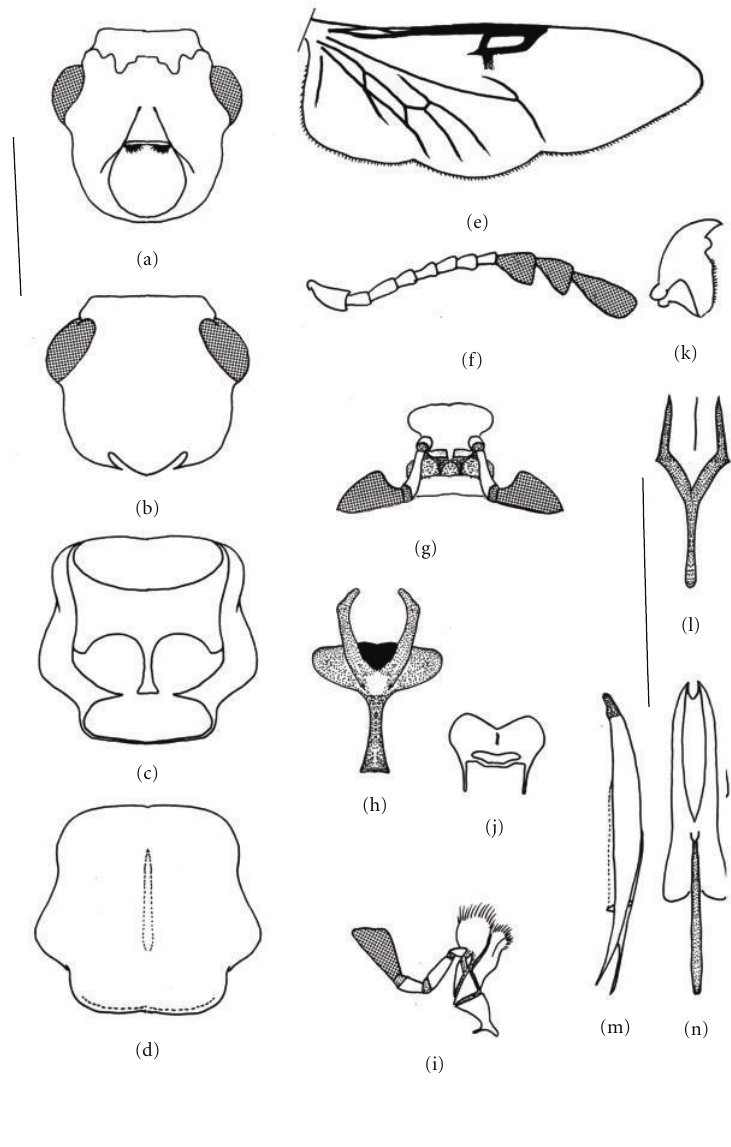
Figure 10: Various organs of Neopylus nahuelbutensis . (a, b) Head ((a) ventral, (b) dorsal). (c, d) Thorax ((c) ventral, (d) dorsal). (e) Metathoracic wing. (f) Antenna. (g) Labium. (h) Metendosternite. (i) Maxilla. (j) Labrum. (k) Mandible. (l) Spiculum. (m) Phallus. (n)